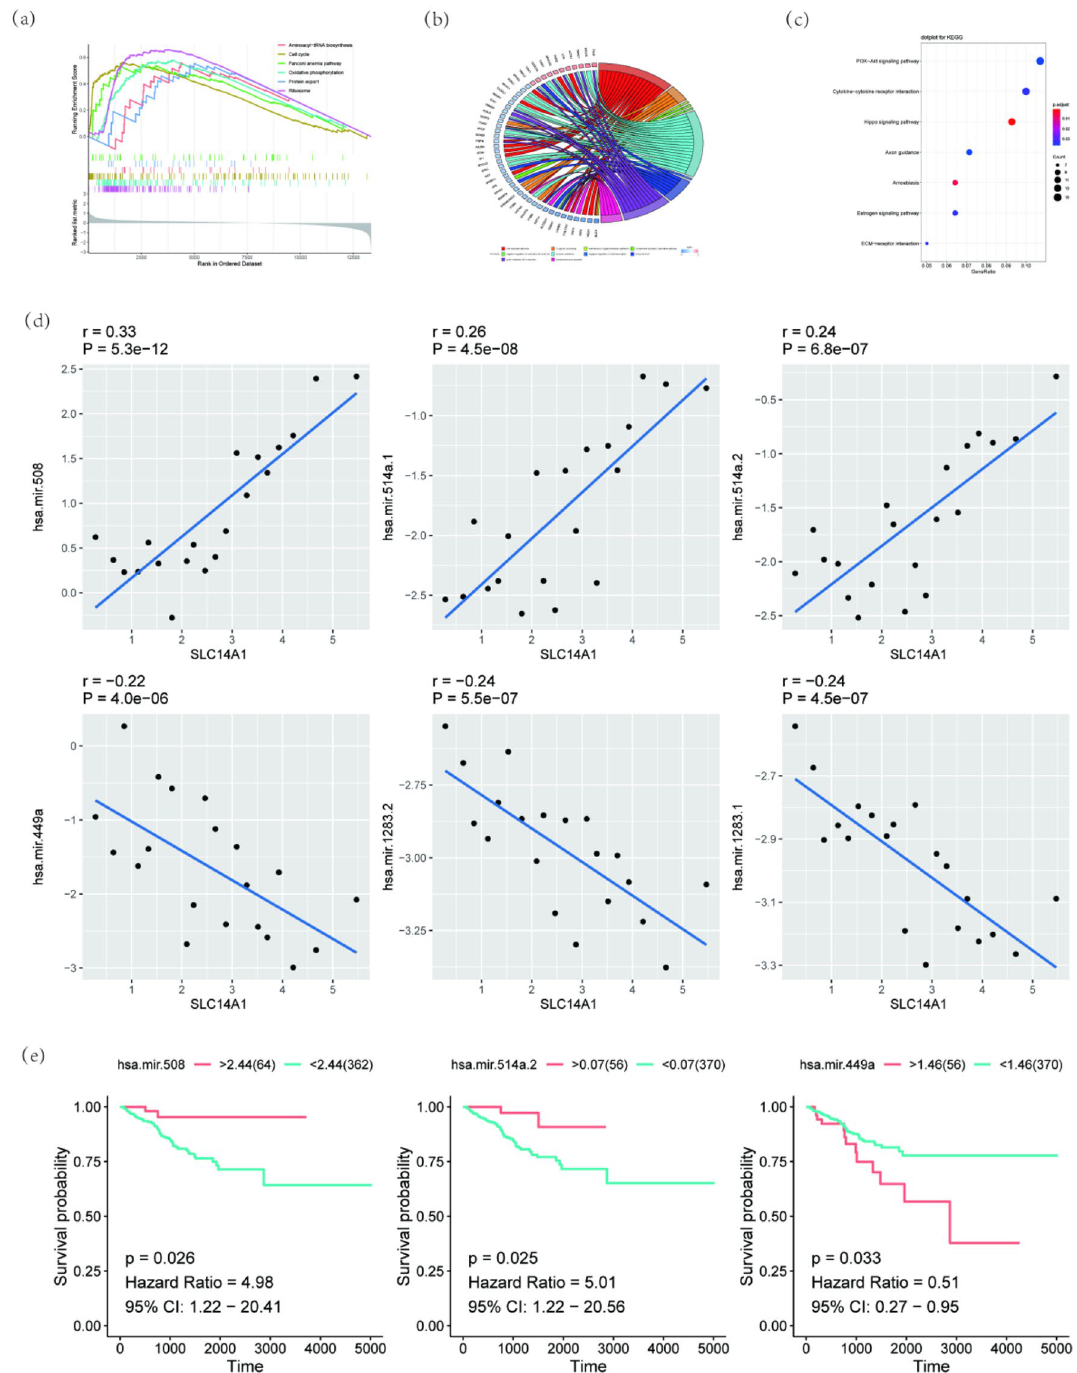
Figure 2. Functional analysis and miRNA association analysis of SLC14A1. ( a ) Gene Set Enrichment Analysis of high expression group and low expression group. ( b ) GO analysis, each strip represents a pathway. ( c ) KEGG analysis. Each small point in the graph corresponds to a pathway, and the color is sorted by p value from small to large according to red, orange, yellow, green, blue, indigo, and purple. The smaller the p value is, the more color tends to red, and the larger the point is, the more genes in the pathway are. ( d ) Correlation analysis between ± top 3 differential expression miRNAs and SLC14A1. ( e ) Kaplan–Meier survival curves of the ± top 3 differential expression miRNAs that had a statistical